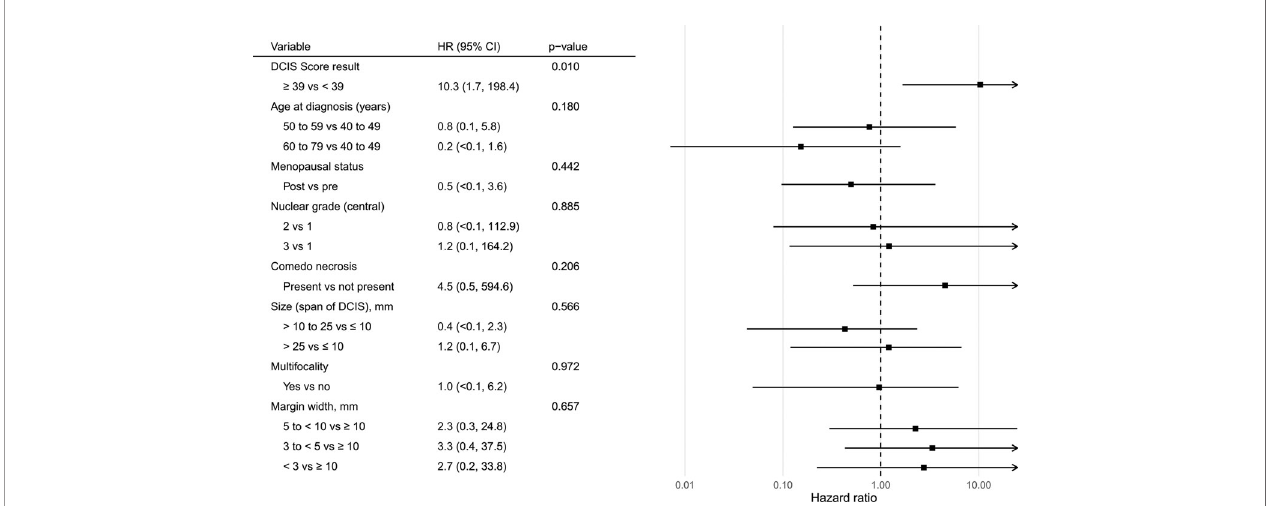
FIGURE 3 | Forest plot of univariable Cox proportional hazards models for risk of ipsilateral recurrence by the DCIS Score result and relevant demographic, clinical, and pathologic